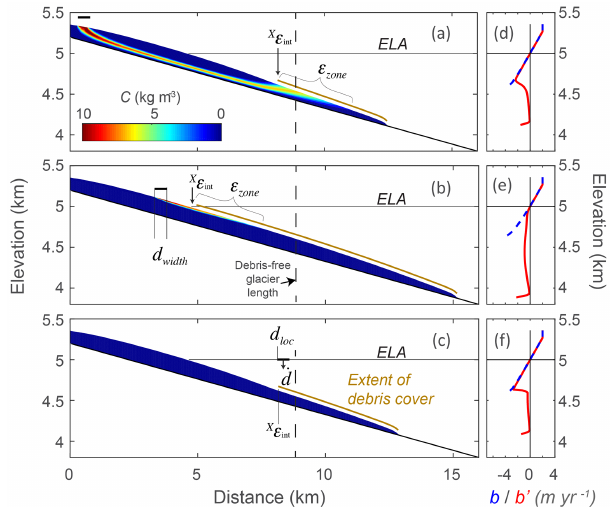
Figure 5. Modeled glacier changes due to changes in debris de- position location with debris flux held constant. Englacial de- bris concentrations (a–c) and mass balance profiles (d–f) for three steady state debris-covered glacier simulations. ˙ d flux = 3 . 2m 3 m − 1 yr − 1 for each panel. (a) d loc is 7% of the steady state debris free glacier length ( L ssdf ) from the head of the glacier. (b) d loc is 42% to L ssdf . (c) d loc = 98% to L ssdf . The increase in melt rate near the toe is related to the thinning of debris due to the d term parameterization. x (cid:15) is the point of initial debris emergence flux int and (cid:15) zone is the length of the glacier over which englacial debris